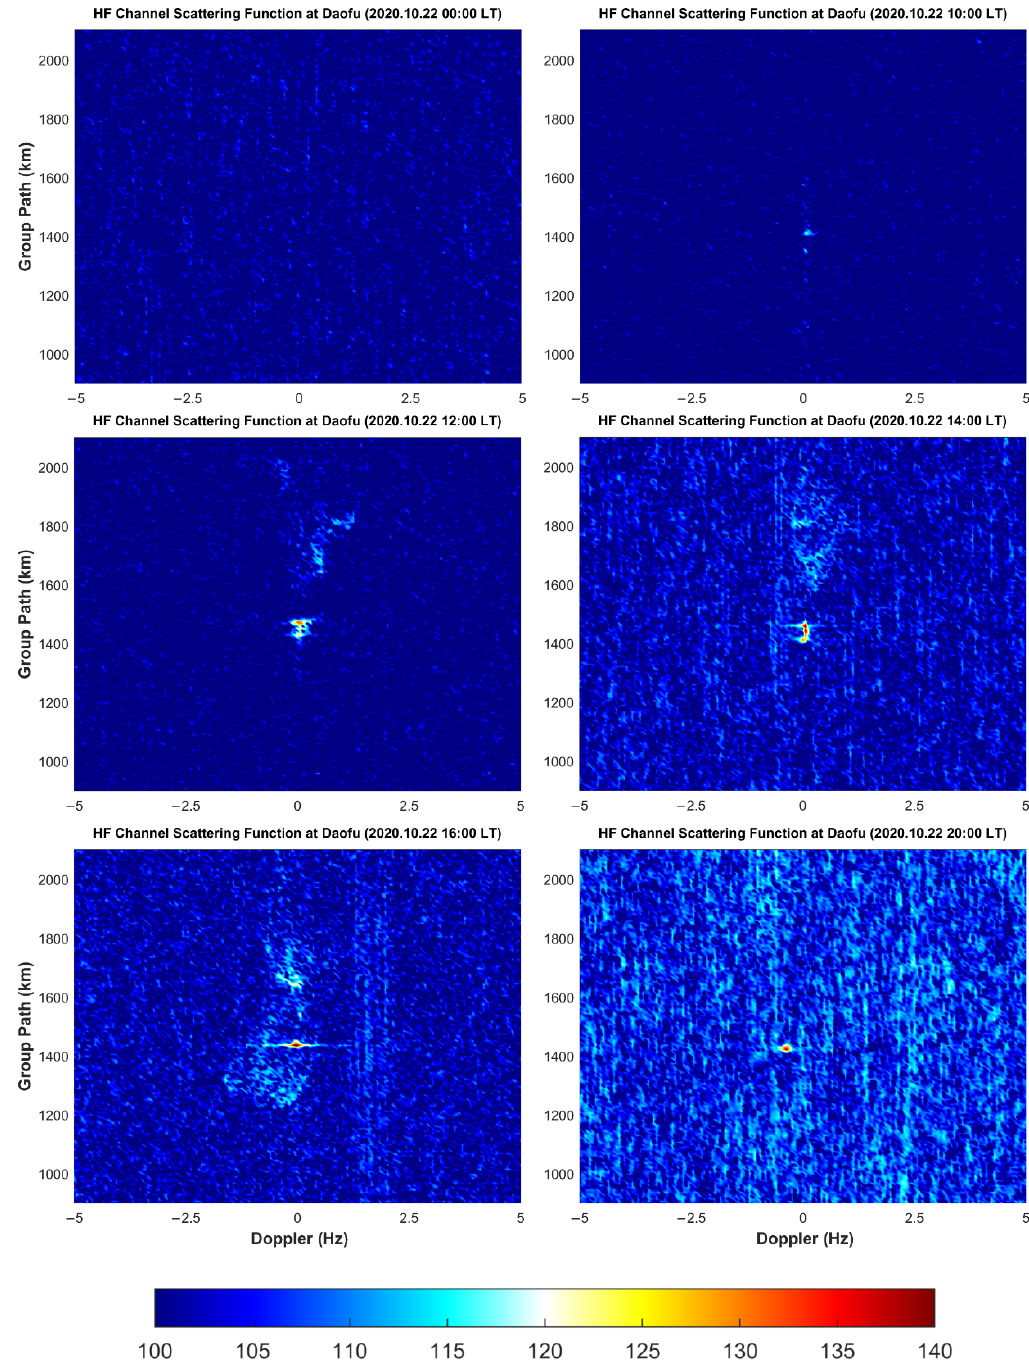
Figure 6. 22 October 2020, data processing results of Daofu station. Refer to the captions in Figure 2 for the receiving time and other descriptions of each panel.